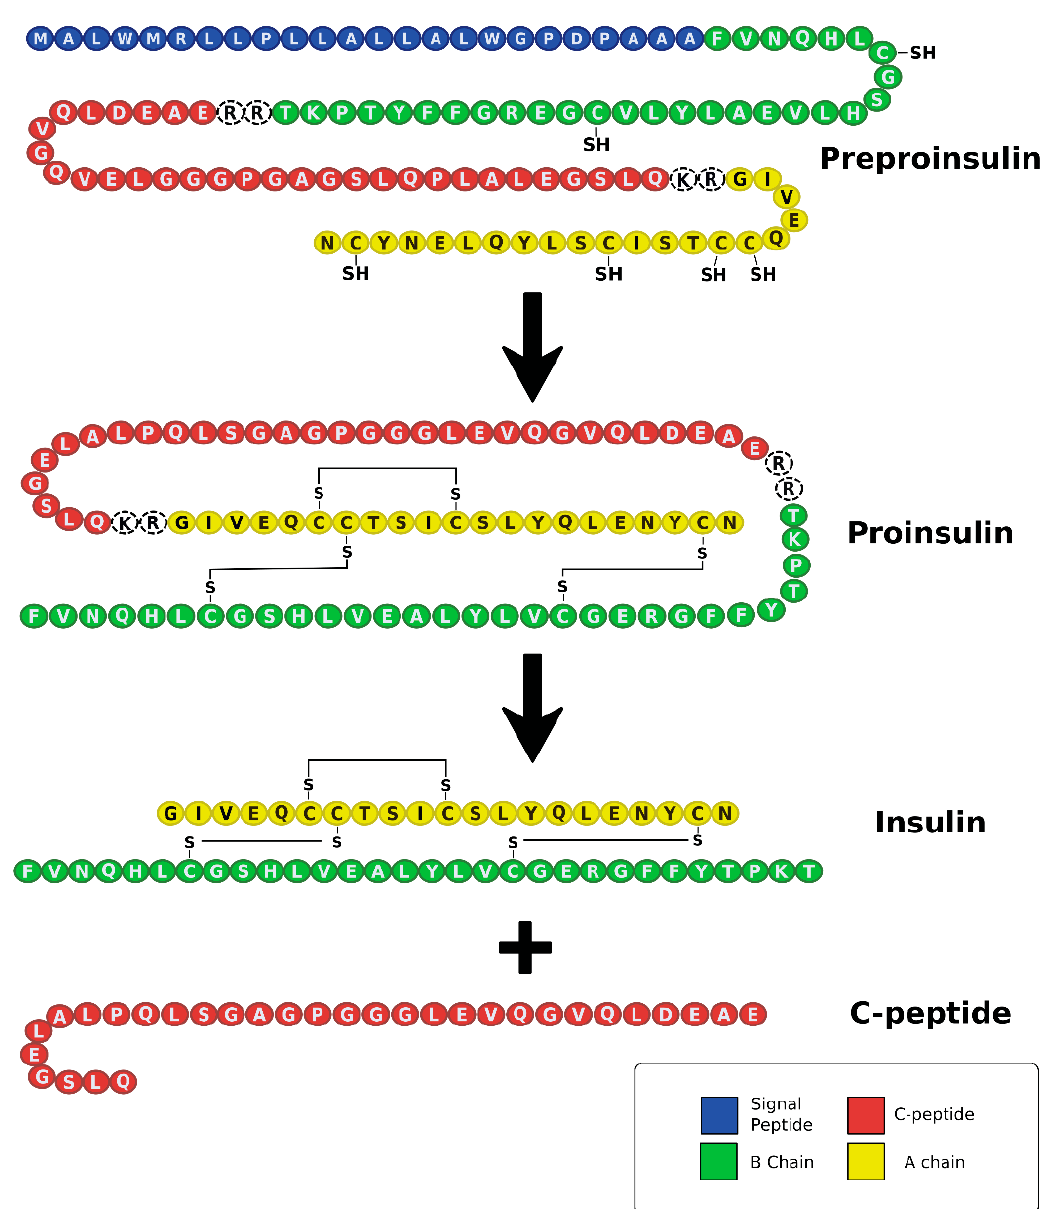
Figure 2. Post-translational modifications of human preproinsulin to produce insulin and C-peptide. After translation of preproinsulin, the signal sequence is cleaved from the main molecule in the rough endoplasmic reticulum, leaving proinsulin. Proinsulin then undergoes folding and three disulfide bonds are formed. Proinsulin is transported to the Golgi apparatus where it is packaged in secretory granules. Within the secretory granules, C-peptide is cleaved from the proinsulin molecule by prohormone convertases (PC) 1 and 2. This cleavage results in the removal of four amino acids (KR and RR) from the final products. PC1 and PC2 are almost exclusively found in pancreatic islet beta cells. C-peptide and the mature insulin molecule are secreted together from the secretory granules [26].